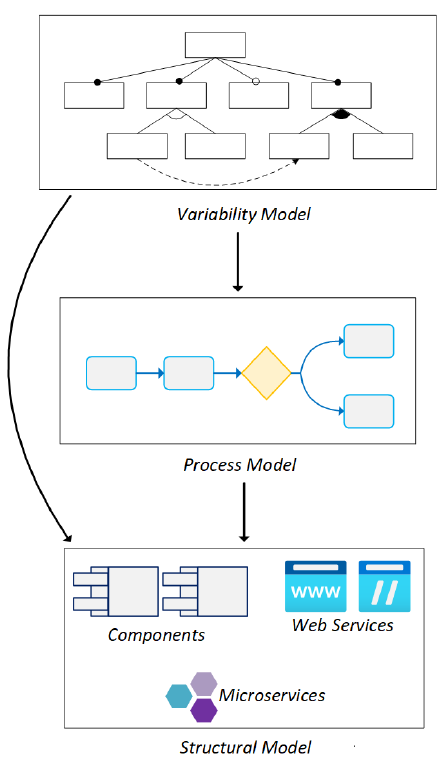
Figure 1. The Reference Model of MSDeveloper.